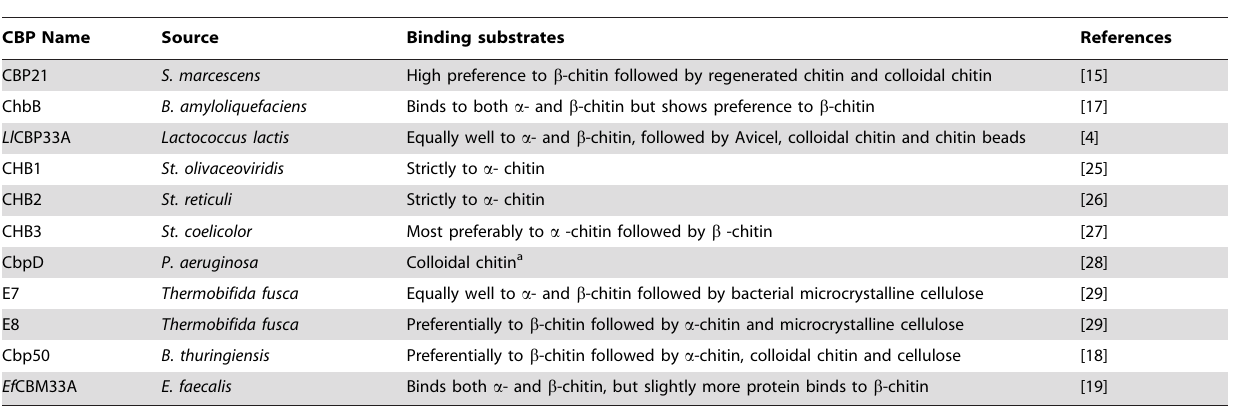
Table 1. Details of bacterial CBPs and their binding